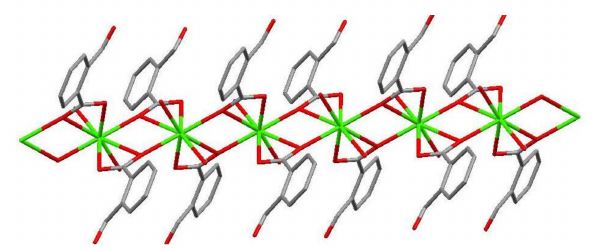
Figure 3. 1D chained structure of Ca(II) coordination polymer.